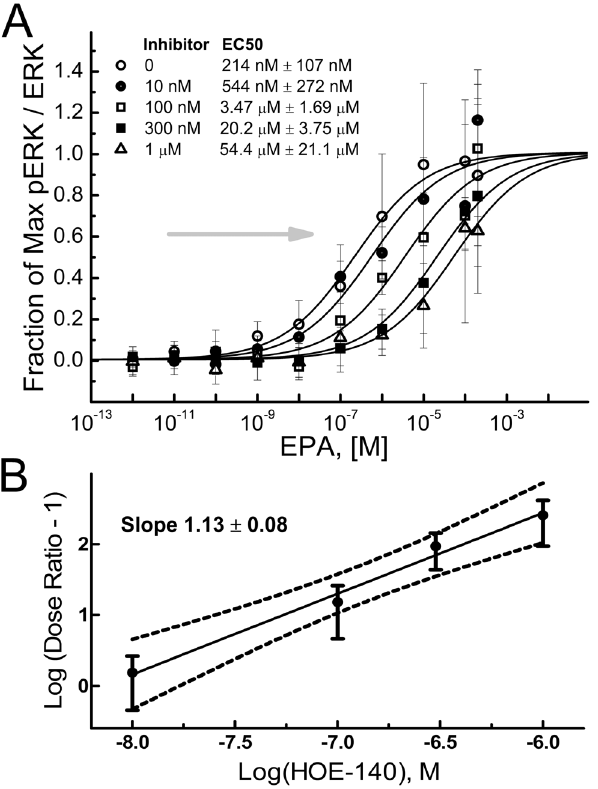
Figure 4. B 2 R antagonist shifts the EPA EC50 by inhibiting ERK1/2 response to fatty acids. (A) Dose response to EPA at different concentrations of antagonist HOE-140 in HEK293 cells. (B) Schild plot of HOE-140 antagonism on EPA-stimulated B 2 R. Experiments were done 24 h after transfection of HEK293 cells with B 2 R in 12-well plates. Ratio of pERK to ERK was measured using western blots. Data represent the mean of at least four independent experiments.